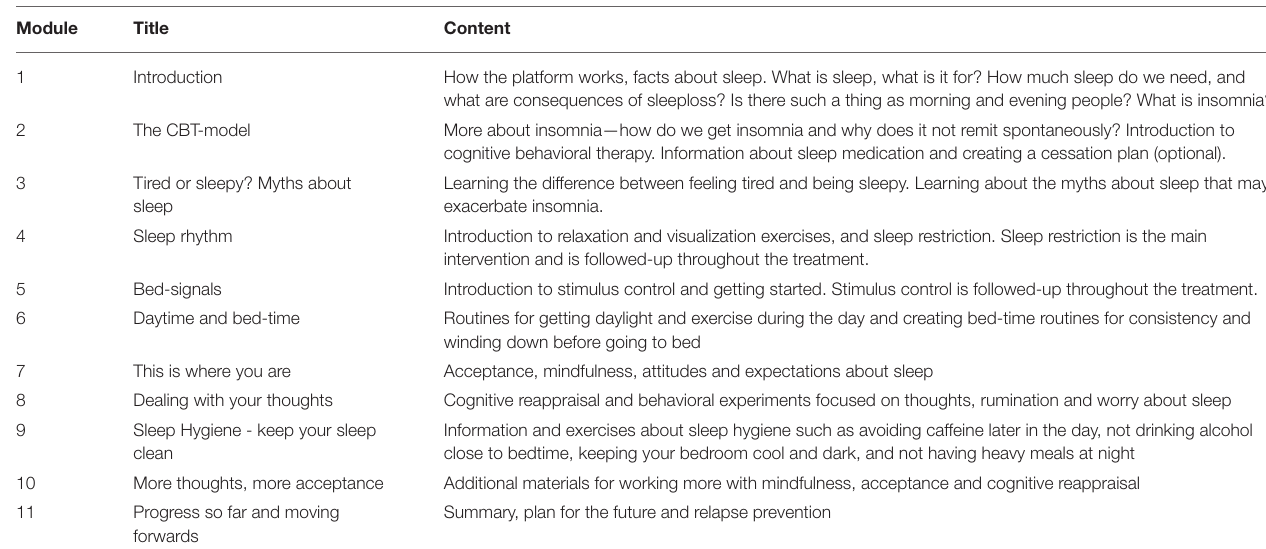
TABLE 1 | ICBT-i treatment